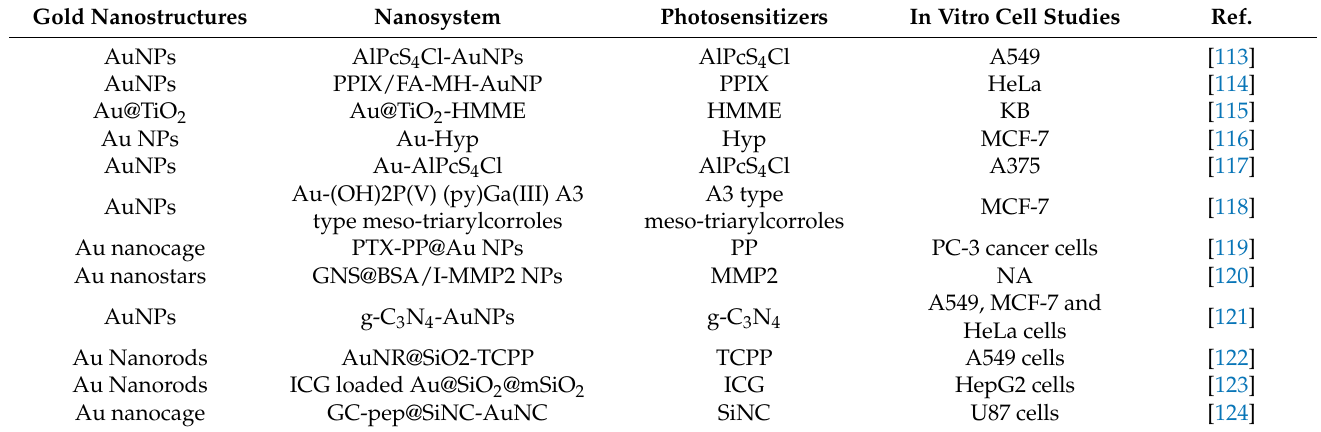
Table 4. Most recent studies involving PS conjugated AuNPs for PDT against cancer using in vitro